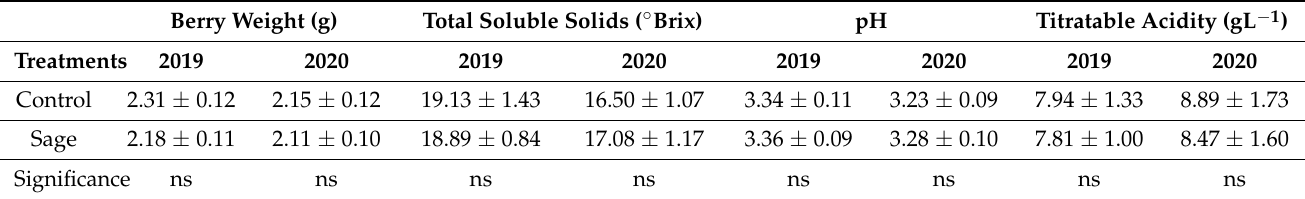
Table 1. Berry weight (g) and technological parameters (total soluble solids, pH, titratable acidity) of samples at harvest for the two vintages. ns: not significant at p ≤